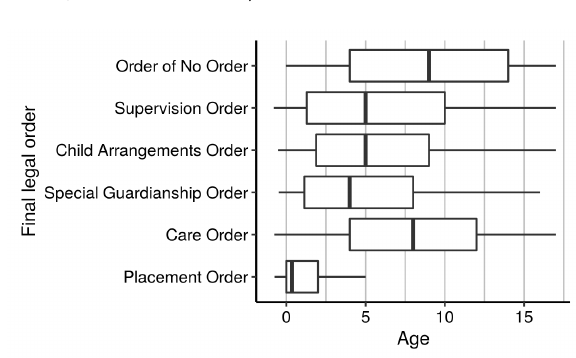
(b) Distribution of age among children receiving specific final legal orders in